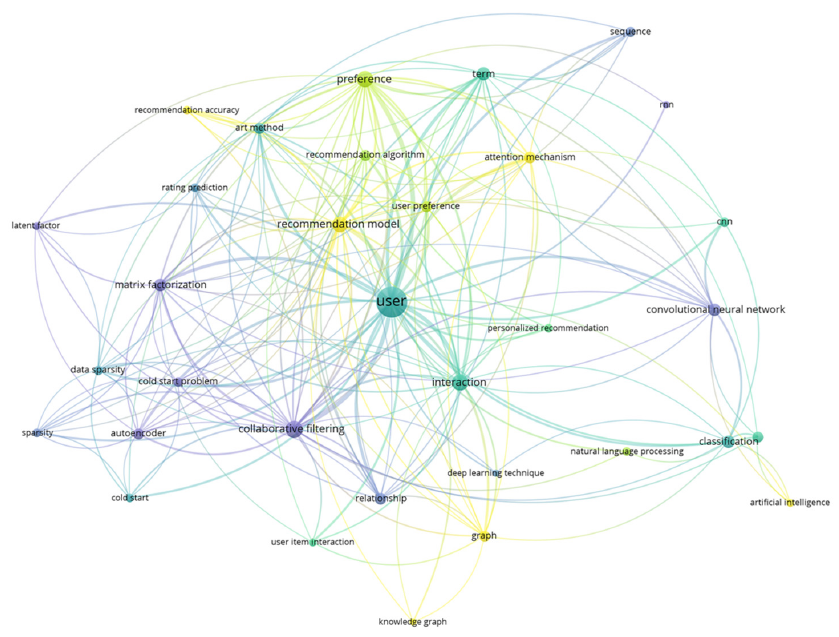
Figure 5. Network connections for the POI recommendation with deep-learning keywords with VOSviewer.